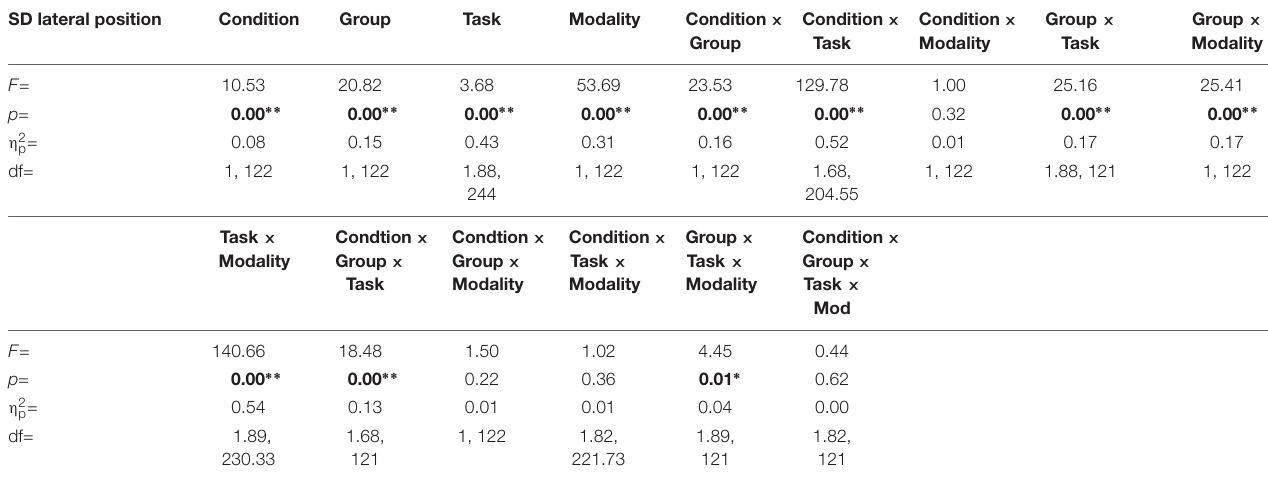
TABLE 4 | ANOVA results for SD lateral position .